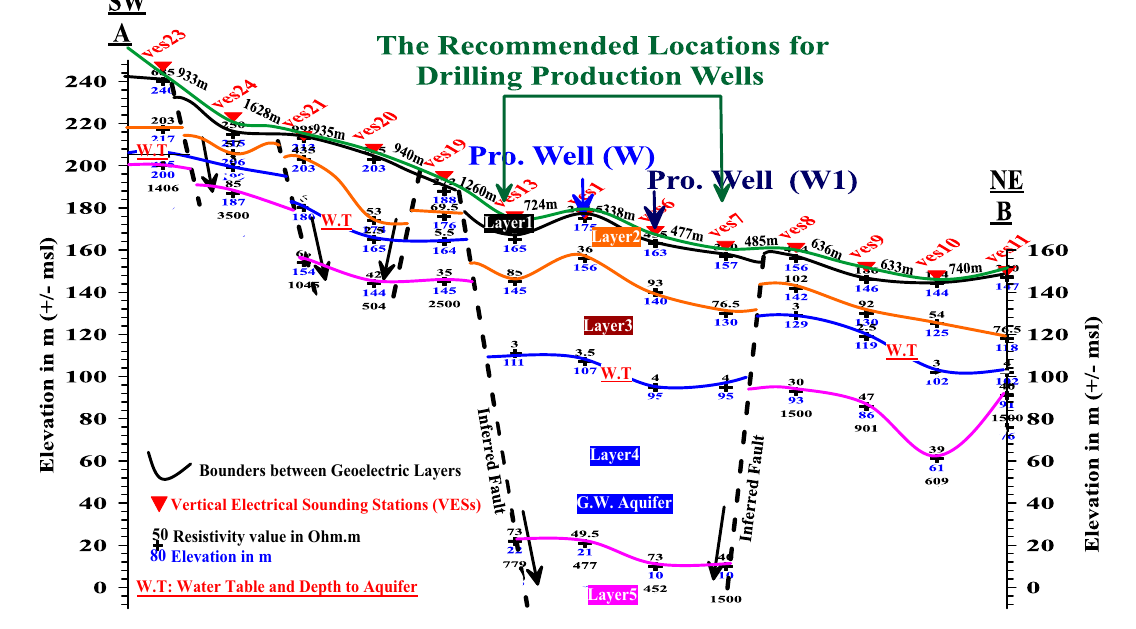
Fig. 6 Hydrogeoelectrical profile (A–B). First geoelectrical layer: dry wadi deposits (124–998 Ω m). Second geoelectrical layer: sand and gravel with minor content of clay (28–435 Ω m). Third geoelectri- cal layer: clay and sandy clay to clayey sand (1.5–30 Ω m). Fourth geoelectrical layer: sandstone, shaly sandstone (27–65 Ω m) to